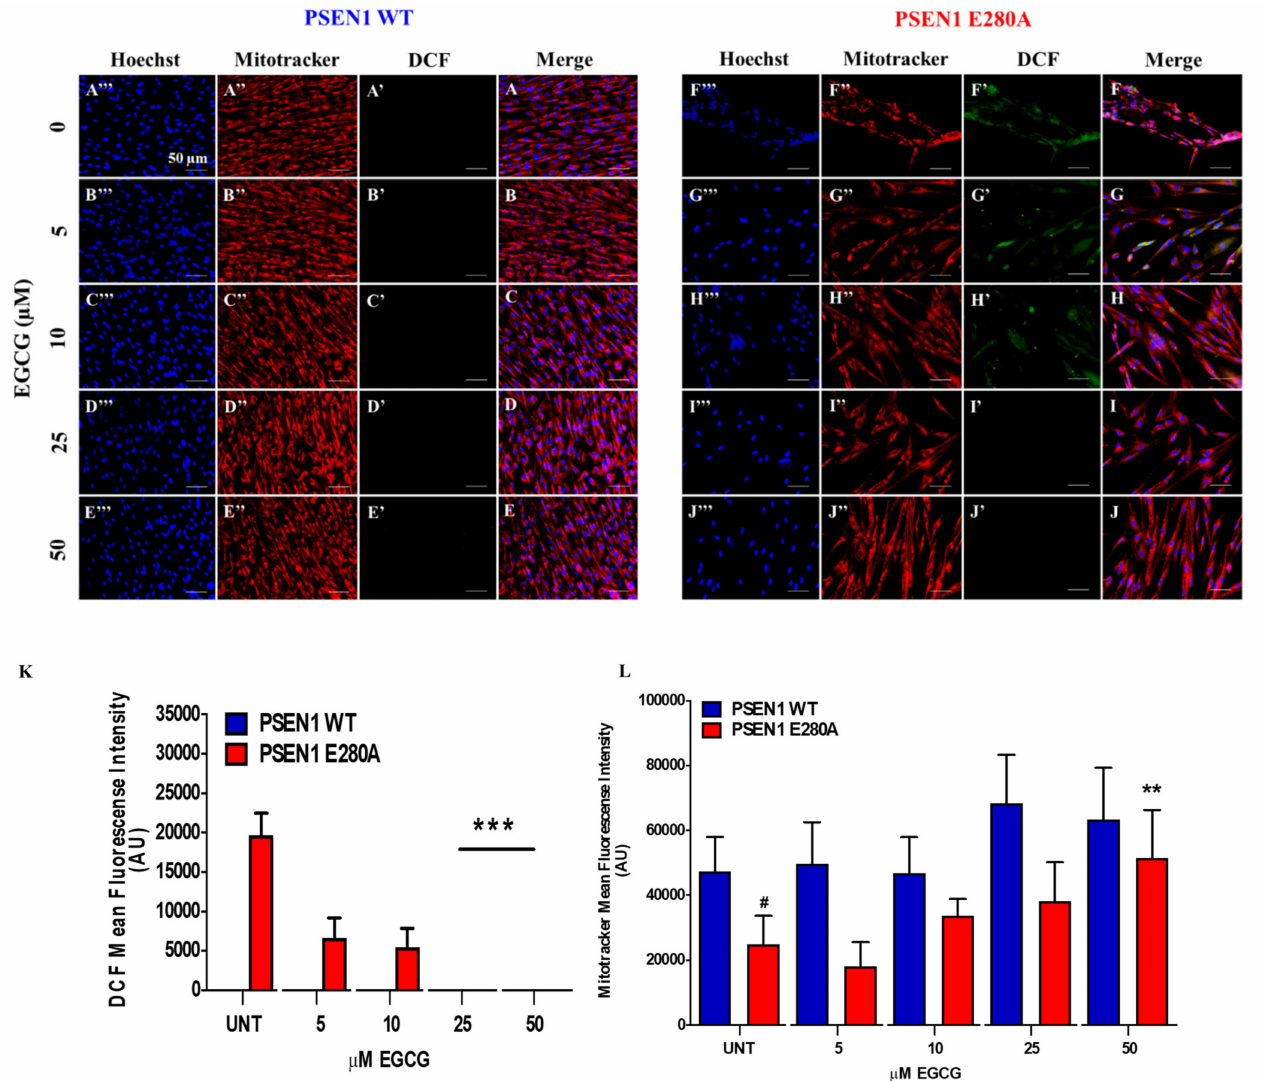
Figure 1. EGCG scavenges reactive oxygen species (ROS) and reestablishes the mitochondrial membrane potential ( ∆Ψ m) in a dependent-concentration manner in PSEN1 E280A ChLNs. After 7 days of transdifferentiation, WT PSEN1 and PSEN1 E280A ChLNs were left untreated or treated with EGCG at increasing concentrations (0, 5, 10, 25, and 50 µ M) in a regular culture medium (RCm) for 4 days. Representative DCF+ cells ( A’ – J’ ), MitoTracker ( A” – J” ), Hoechst ( A’’’ – J’’’ ), and merged ( A – J ) pictures of WT PSEN1 and PSEN1 E280A ChLNs treated as described. ( K ) Quantification of DCF fluorescence intensity. ( L ) Quantification of MitoTracker fluorescence intensity. Data are expressed as the mean ± SD; # p < 0.05; ** p < 0.01; *** p < 0.001. #, ** represents differences compared to UNT PSEN1 E280A cells. The histograms and figures represent 1 out of 3 independent